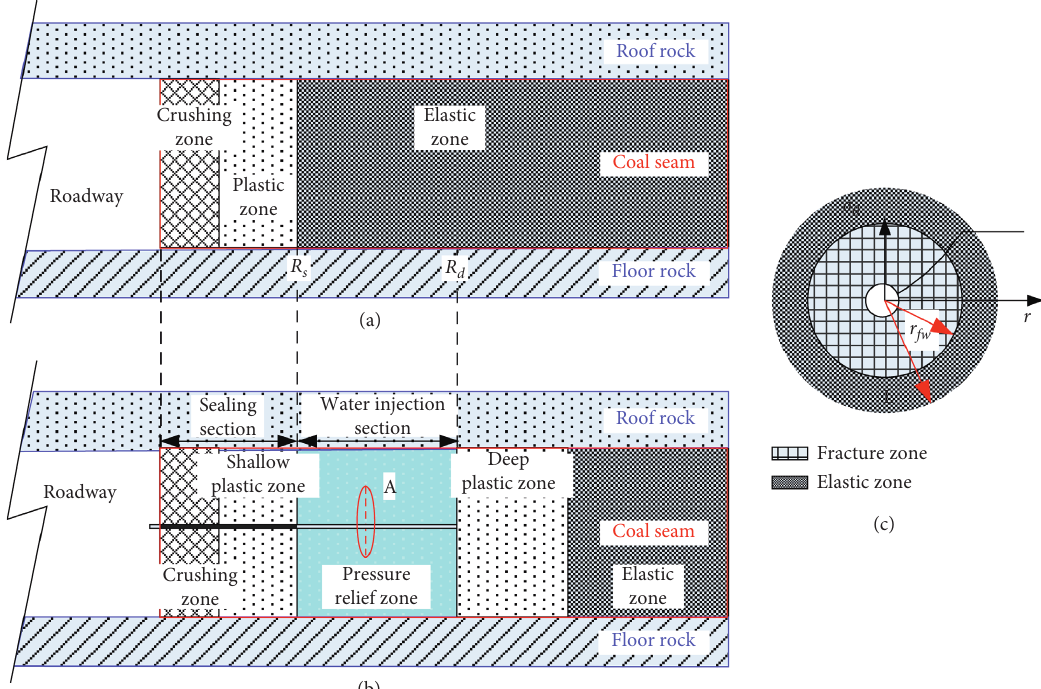
Figure 4: Zones in roadway sidewall after hydraulic fracturing: (a) zones of the roadway sidewall before hydraulic fracturing, (b) zones of the roadway sidewall before hydraulic fracturing, and (c) fracture zone and elastic zone around the water injection hole in section